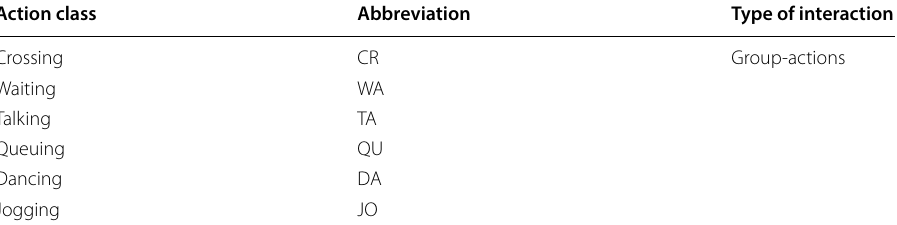
Table 5 Action class categories in collective action dataset with abbreviation Action